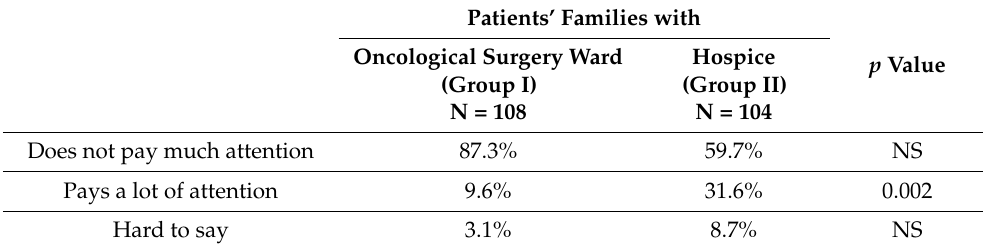
Table 12. The respondents’ opinions on the public focus on palliative care.